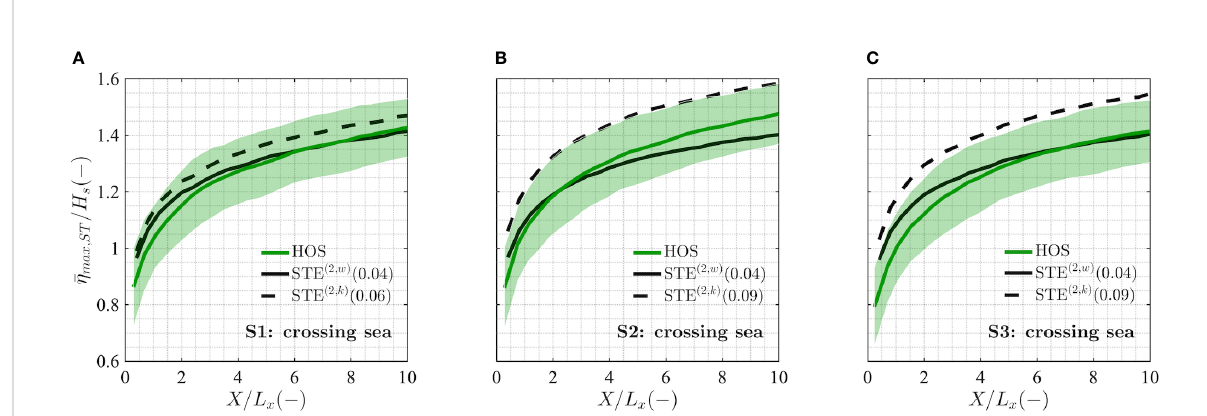
FIGURE 12 Empirical space-time mean values of normalized maximum wave crest height ( (cid:1) h max,ST /H s ) as a function of the normalized sea surface area width ( X/L x ) for crossing sea conditions S1 (A) , S2 (B) and S3 (C) . The standard deviation of the empirical distributions (shaded area) is also shown. Reference statistical distributions for space-time extremes: second-order weighted (STE (2,w) , solid black) and second-order including interaction kernels (STE (2,k) , dashed black). In brackets we display the value of the respective steepnesses